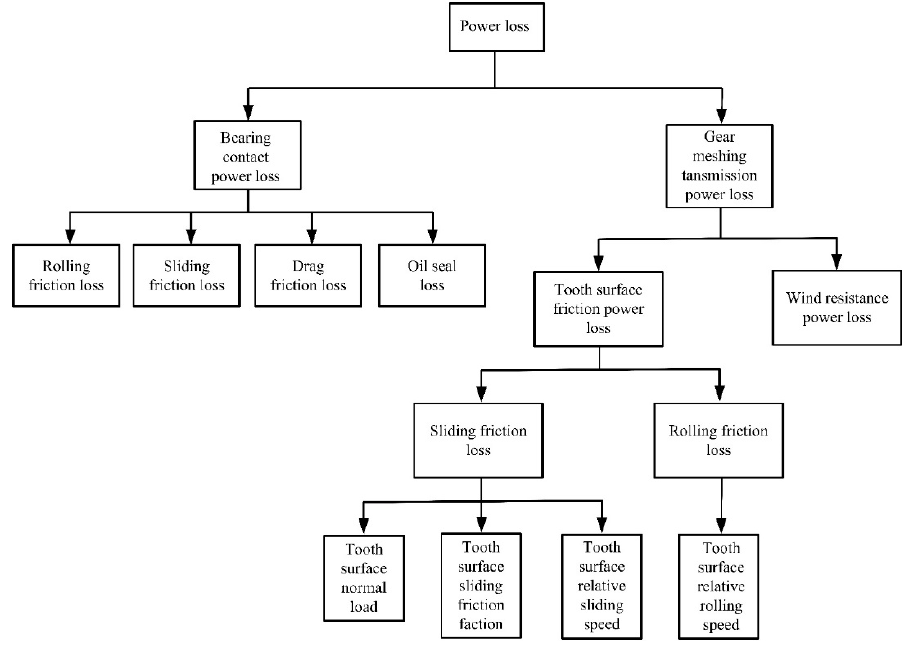
ff ecting gear transmission power loss. Figure 4. Main factors affecting gear transmission power loss. Figure 4. Main factors a